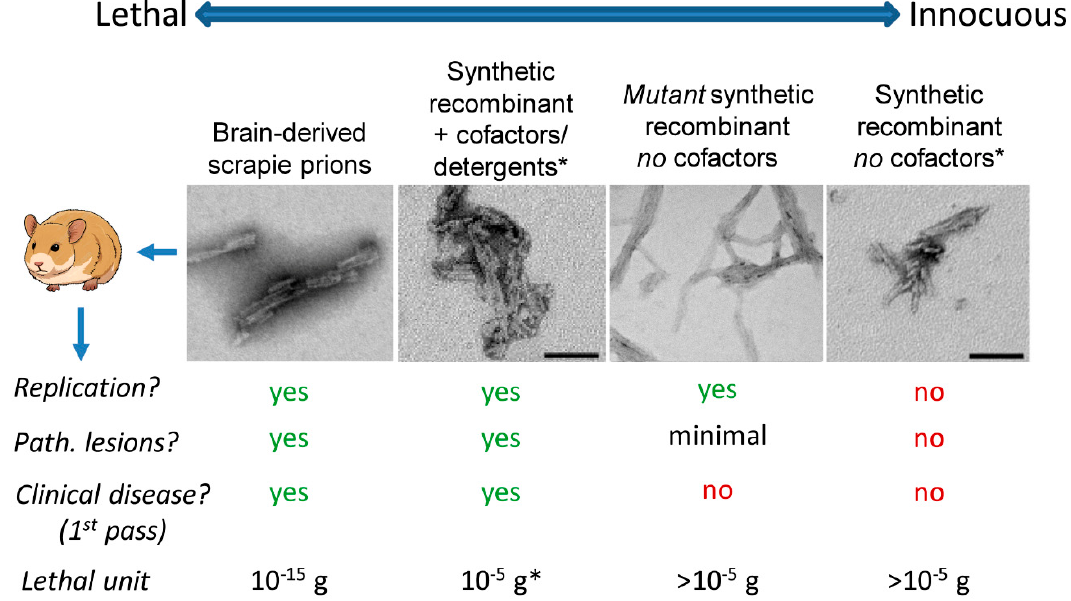
Figure 1. Spectrum of transmissibilities and pathogenicities of hamster PrP amyloids. Each of the pictured amyloid fibrils can e ffi ciently seed the continuous propagation of amyloid fibrils in vitro, but di ff er markedly in the consequences of their inoculation in vivo. The images are negatively stained transmission electron micrographs with the bar spanning 100 nm. * These panels adapted from [31]. Although the fibrils depicted in second panel from left was prepared with detergent [31] and only barely lethal [32], it is important to note that other synthetic recombinant prions prepared with cofactors can be orders of magnitude more lethal per unit protein (lethal unit of ~10 -10 g) [33]. “Path.” stands for neuropathological. For further information on the “mutant synthetic recombinant no cofactors” fibrils, see [34].